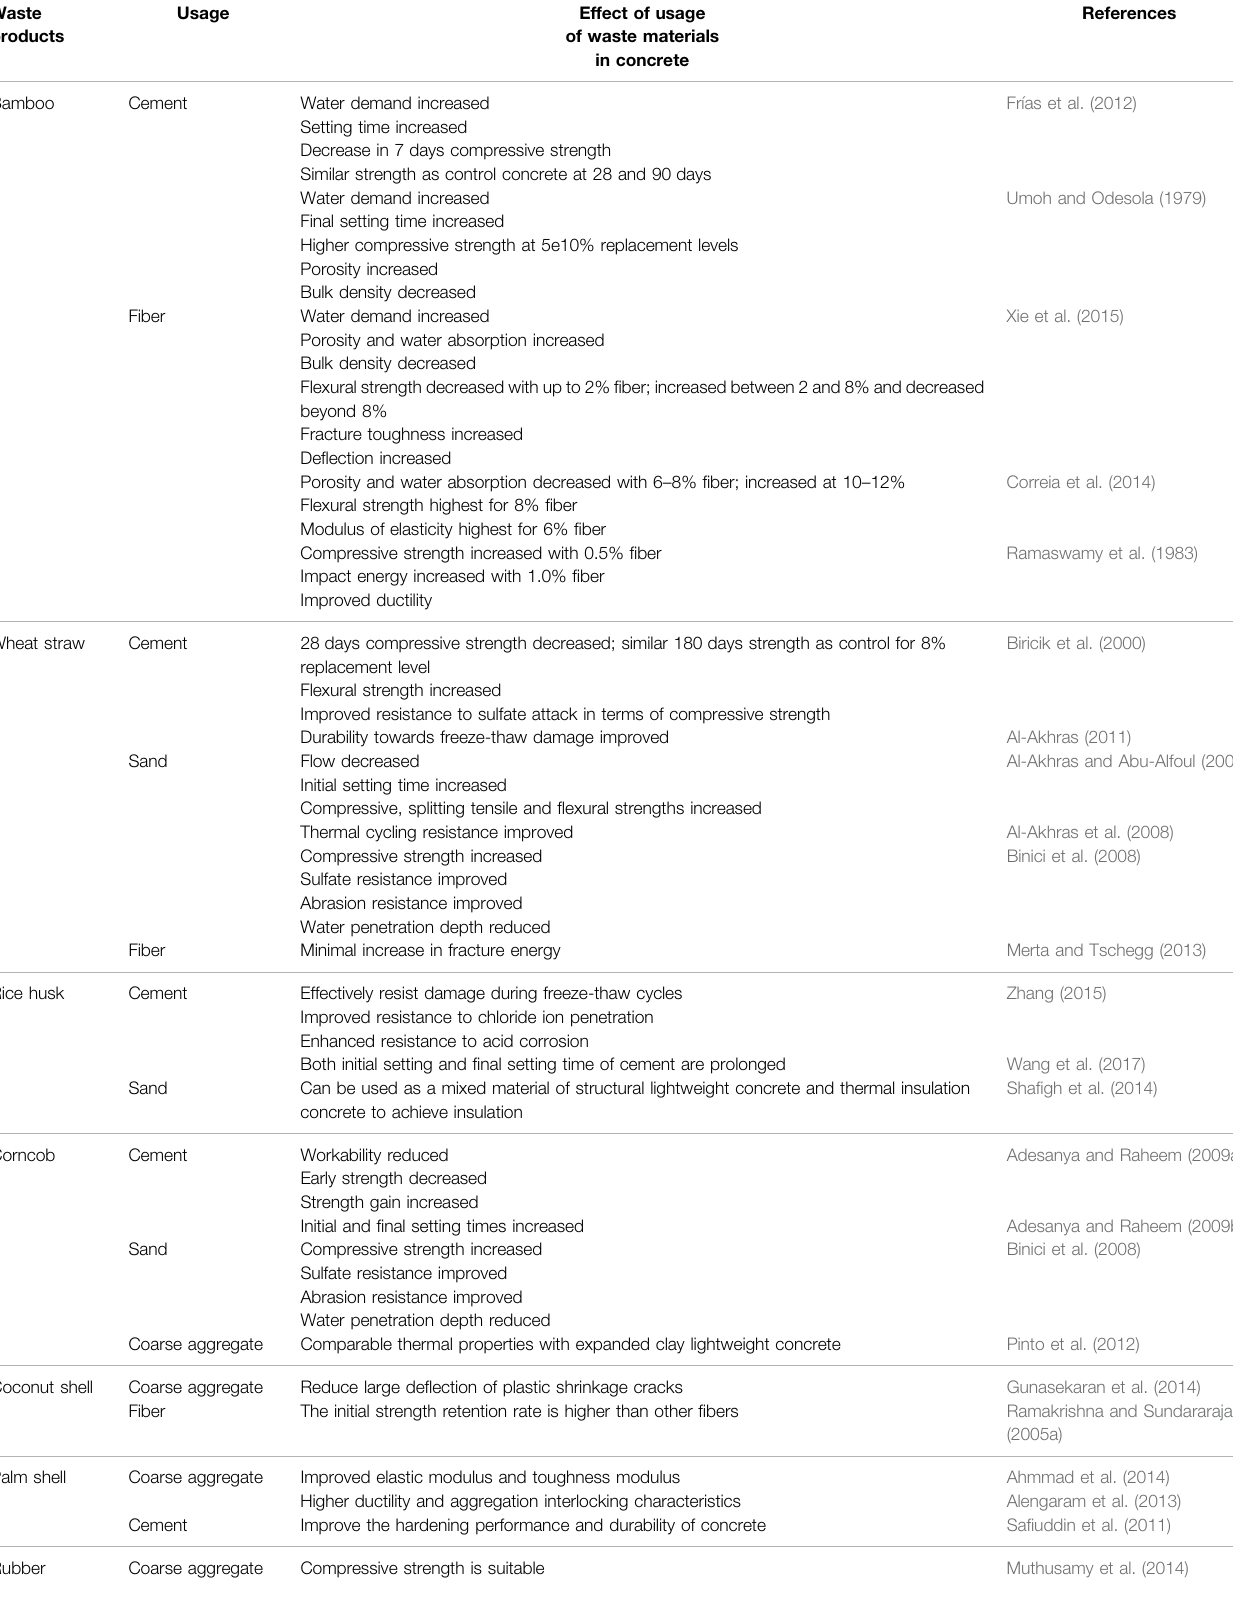
TABLE 5 | Usage of multi-application waste in